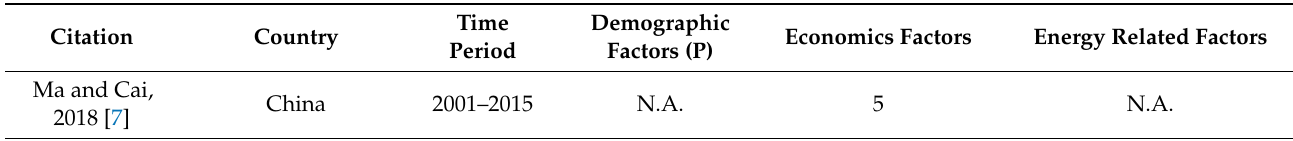
Table 1. Summaries of the previous empirical investigations on GHG emissions based on Kaya